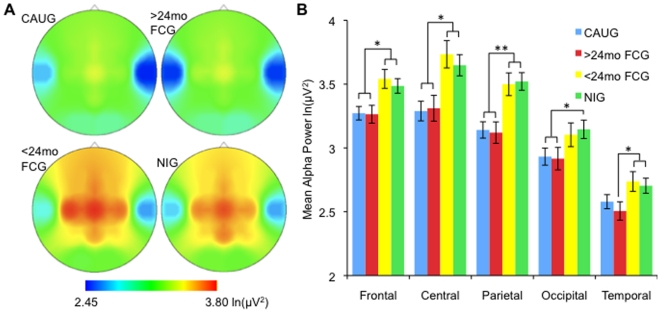
EEG scalp distribution of alpha power.(a) Scalp topography of alpha power demonstrating the timing effects for care-as-usual group (CAUG; N = 48), foster care group placed after 24-months (>24mo FCG; N = 28), foster care group placed before 24-months (<24mo FCG; N = 25), and the never-institutionalized (NIG; N = 42) group. (b) Mean alpha power across the sites for each group (* p<.05; *** p<.005).